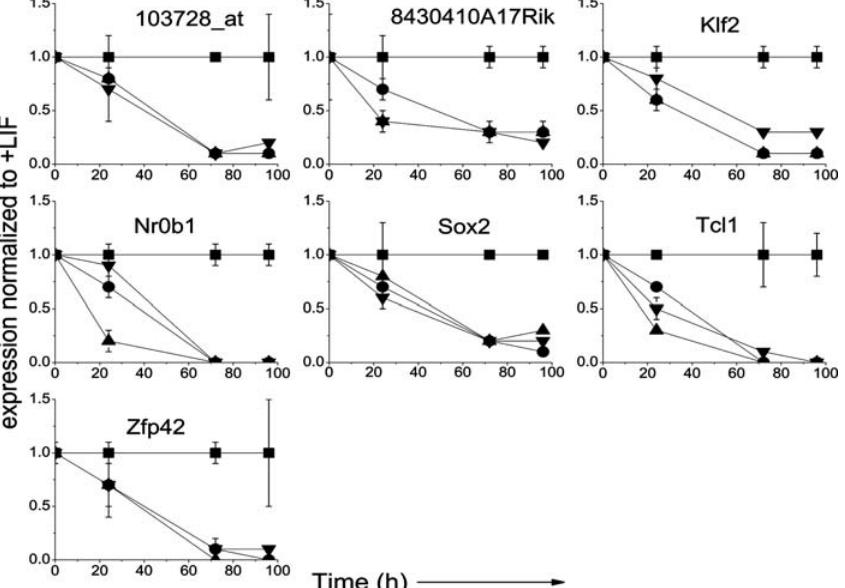
Figure 5. Q–RT–PCR Profiles of Transcript Levels for Seven Genes That Showed Rapid Decrease in ESC Populations When Subjected to a Variety of Differentiating Conditions All levels of expression are relative to the þ LIF control. þ LIF control ¼ & , –LIF ¼ (cid:1) , –LIF þ DMSO ¼ m , þ LIF þ RA ¼ . . doi:10.1371/journal.pcbi.0020158.g005 PLoS Computational Biology |